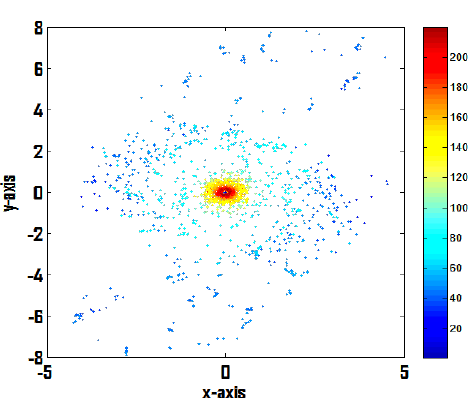
Fig.2: Rotation curve of the spiral hot diskmodel aftermany million years.